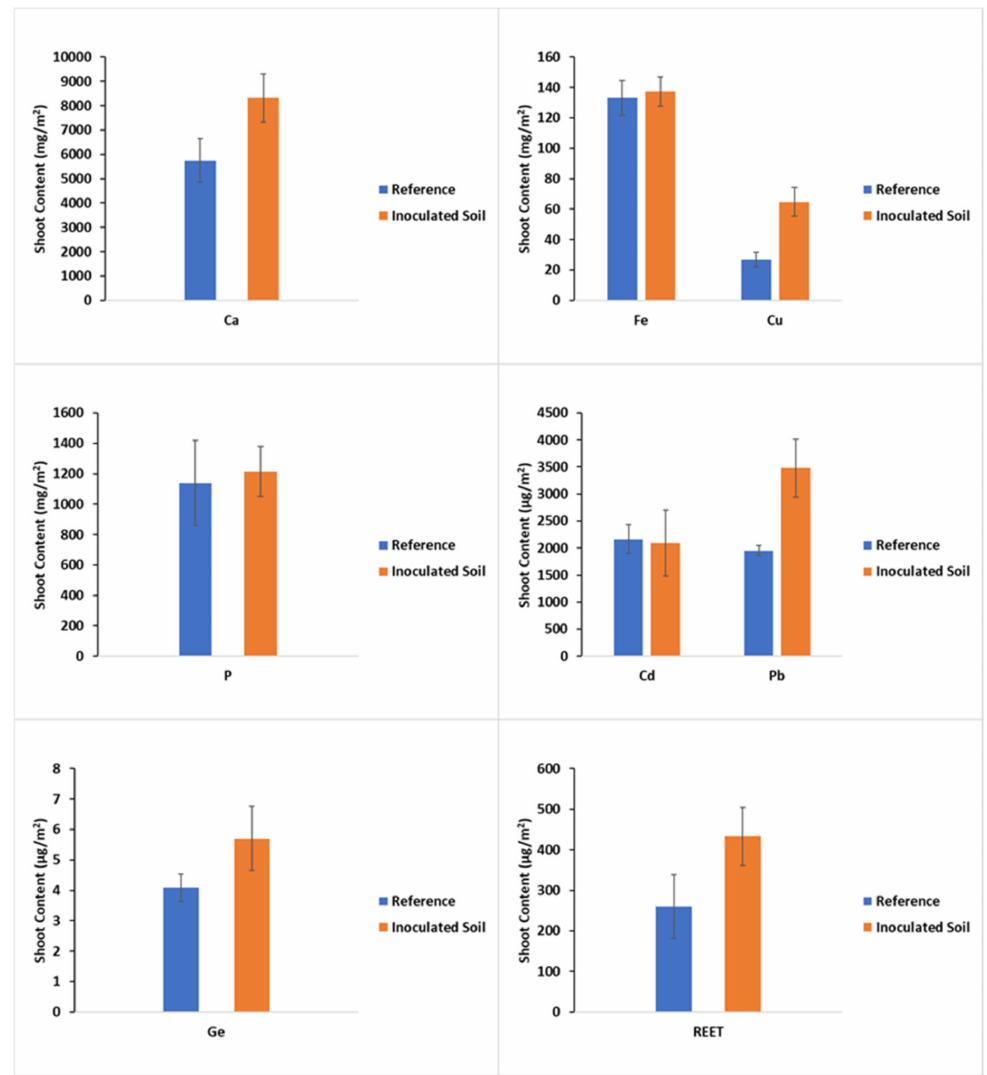
Figure 4. Effect of soil inoculation on element accumulation in above-ground biomass of Helianthus annuus (mean ± SE, n =